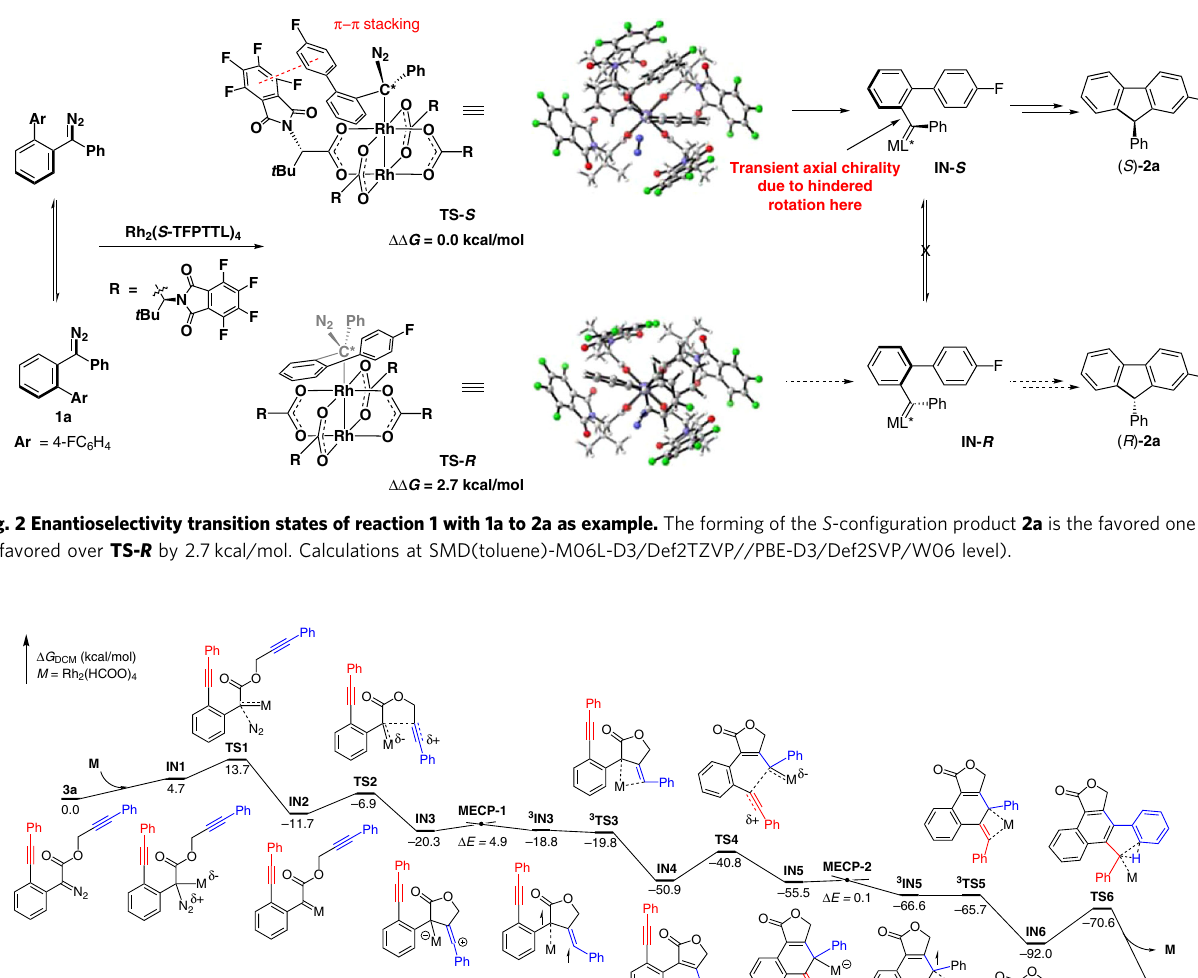
Fig. 3 Gibbs energy pro fi le for catalytic cascade reaction 2 with 3a to 4a as example. The discovery of carbene – Rh-dimer complex formation via ISC process in CAM process. Calculations at SMD(DCM)-M06L/6-311G(d,p)&SDD//PBE/6-31G(d)&SDD level). MECP minimum energy-crossing